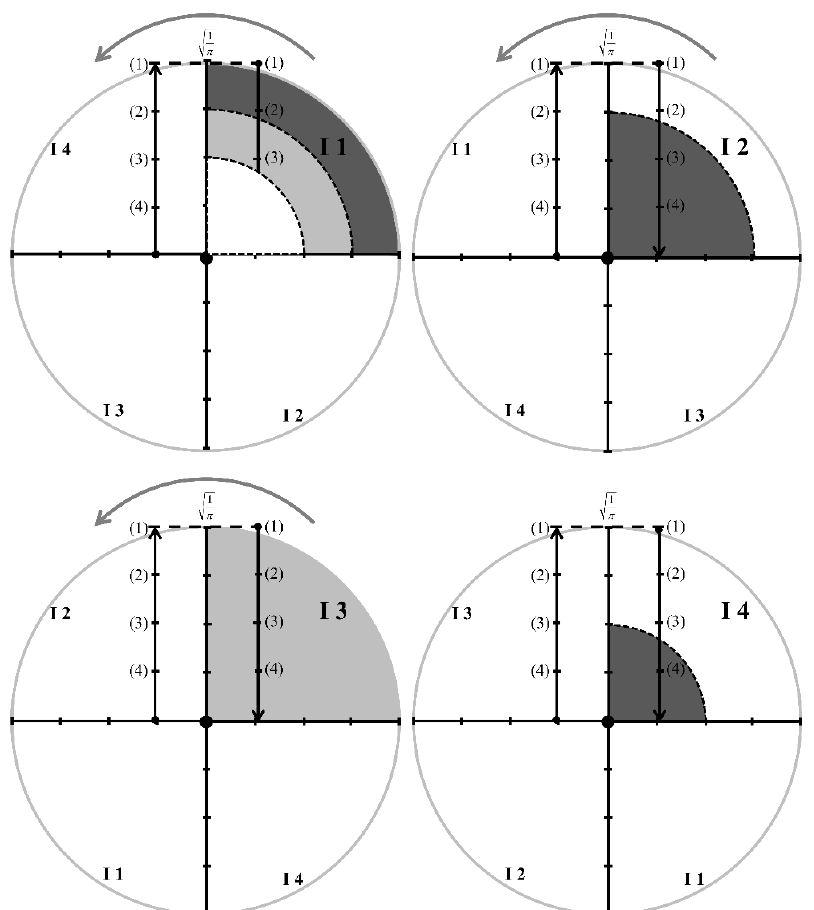
Figure 2: A global view of the energy that an employee is predicting to be used by the system to be in the entropic state suggested by his/her responses to ORI – 4 , per item. The dark areas stand for exergy, gray areas denote vagueness and white areas represent anergy